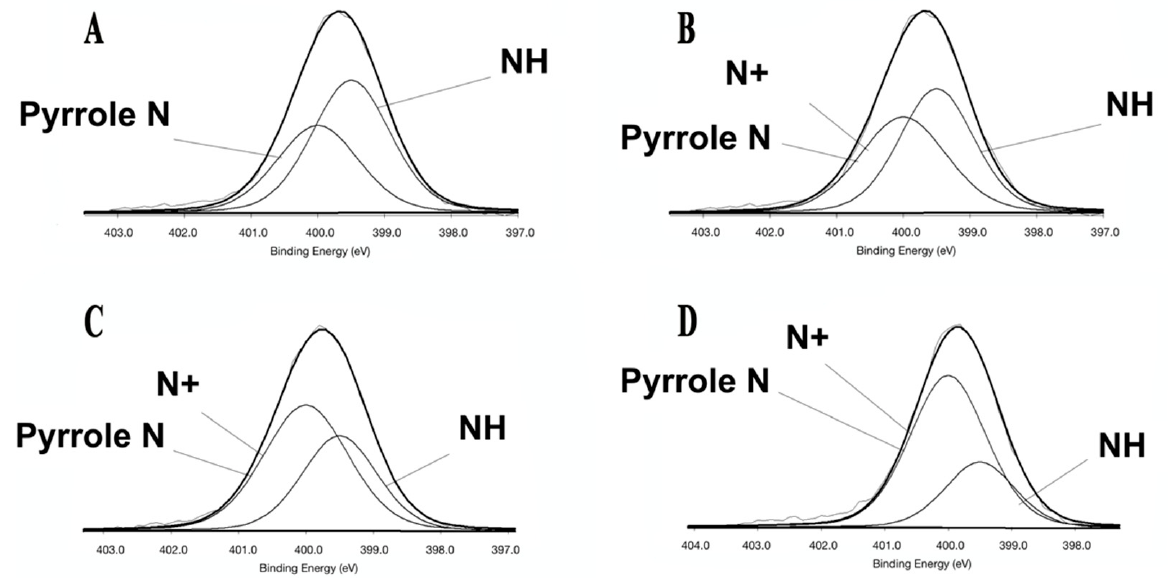
Figure 3. Adsorbed content on the collagen surface after TMC treatment detected by